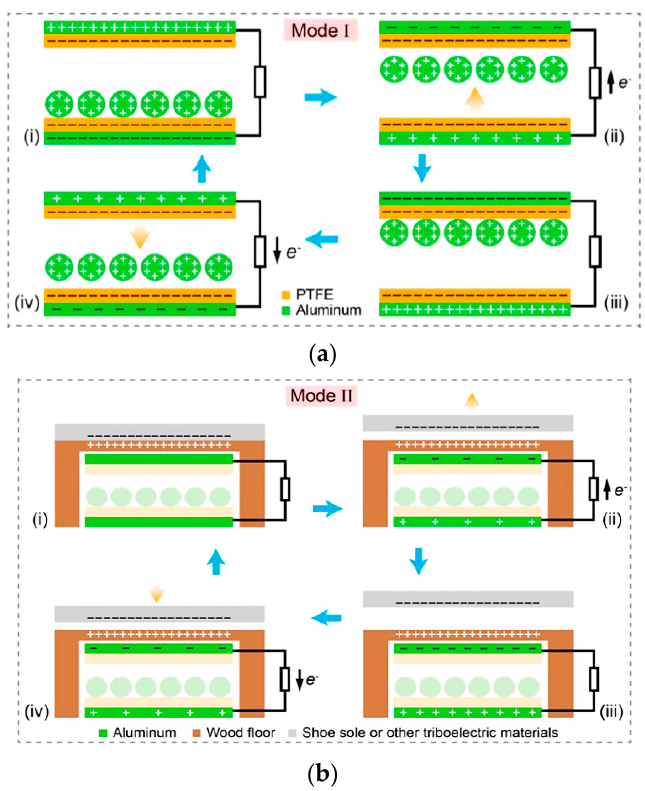
Figure 24. Operating modalities of the SF-TENG, Mode I ( a ) and Mode II ( b ) [58]. However, the power output is low for energy harvesting, and the best technology